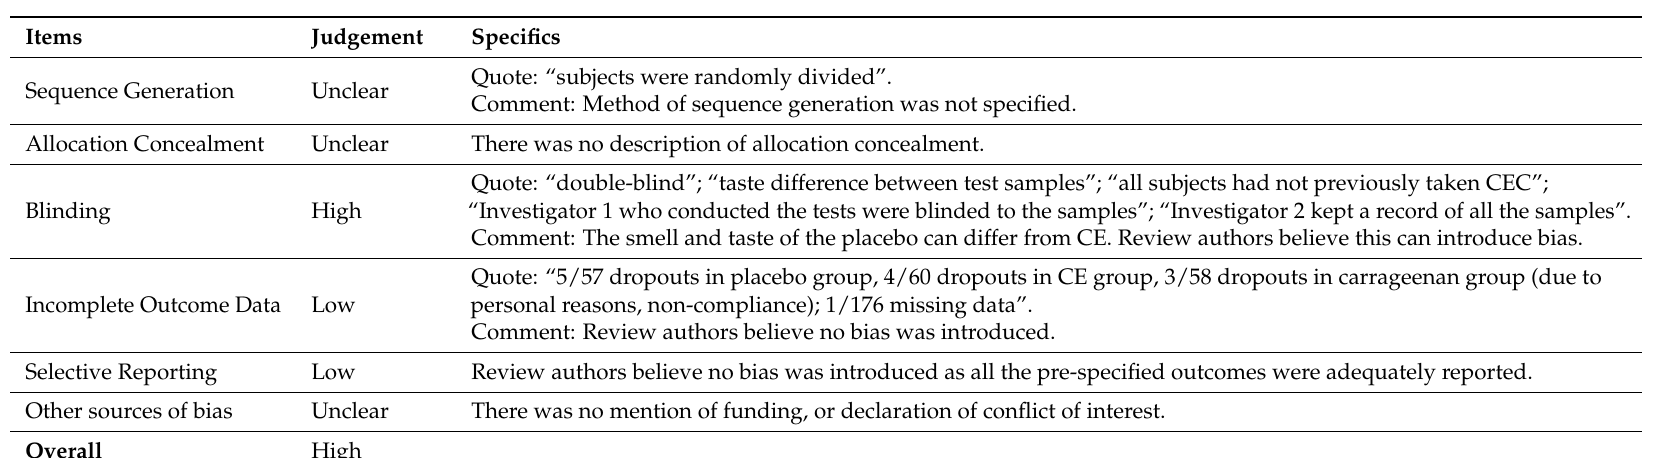
Table A2. Risk of bias assessment of Azhar 2003,